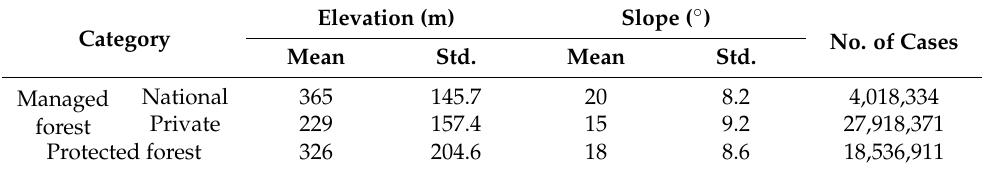
Table 6 indicates the characteristics of managed and protected forests by type and age-class distribution. Of the 3,280,836 ha of forests, including unstocked forests, the rate of plantation forests was higher in managed forests (398,300 ha, 12.1%) than in protected forests (179,900 ha, 5.5%). Regarding protected forests, the area equal to or younger than age-class III (30 years old) was 198,920 ha, whereas that with equal to or older than age-class